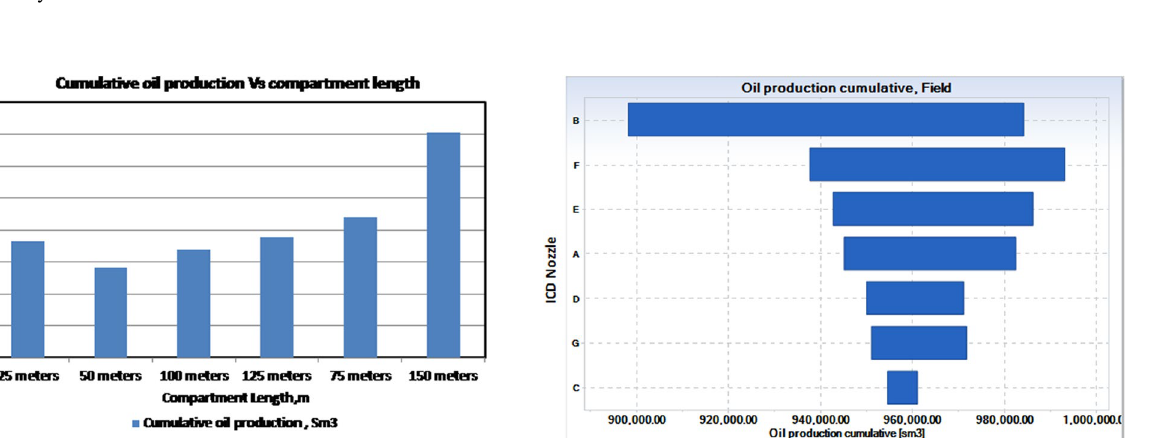
Fig. 7 Sensitivity results of horizontal well